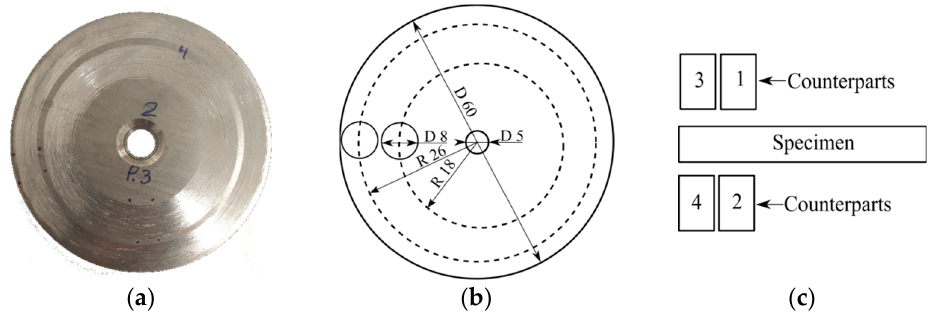
Figure 1. Positioning of the specimens and pin counterparts: ( a )—tested specimens, ( b , c )—dimensions and positioning of the counterparts on the disc surfaces and the order of the wear